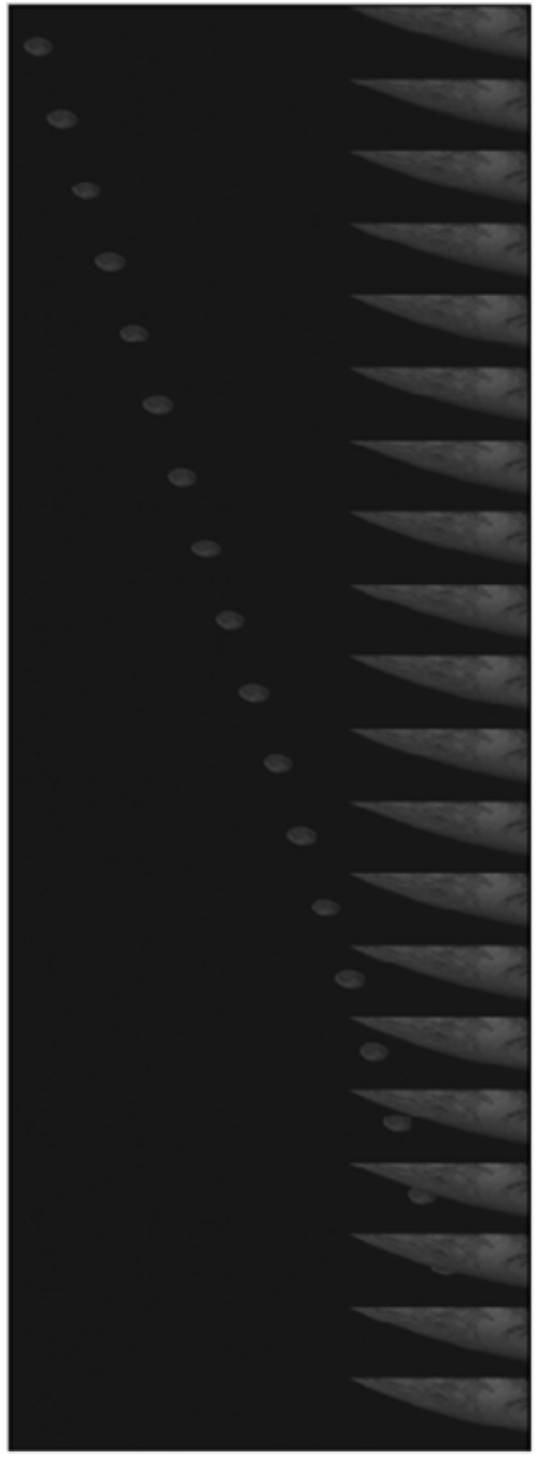
Figure A2. Series of images taken for lunar observation on 28 July to test the scan mechanism and accuracy of the coordinate